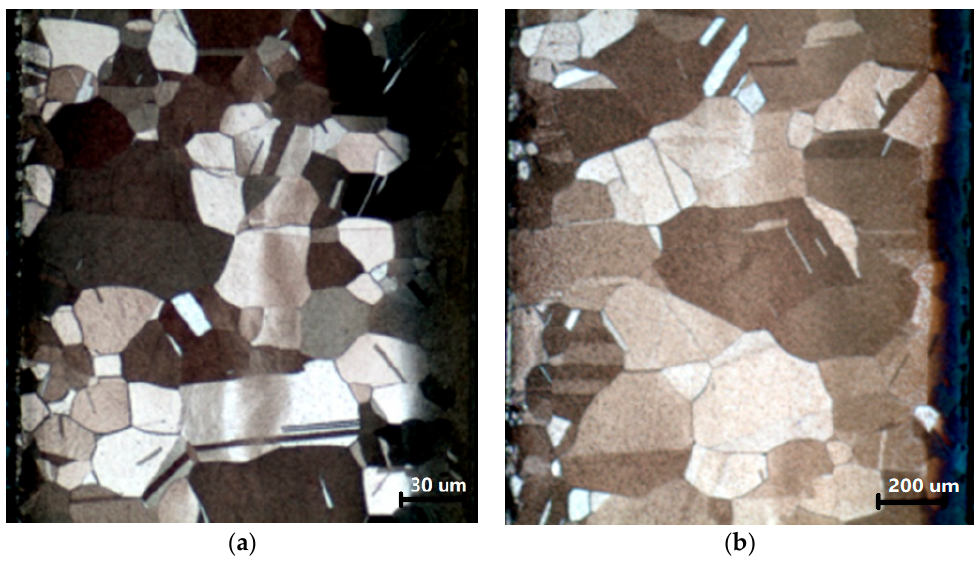
Figure 6. Microstructure distribution after annealing process ( a ) 32 µm and ( b ) 240 µm.